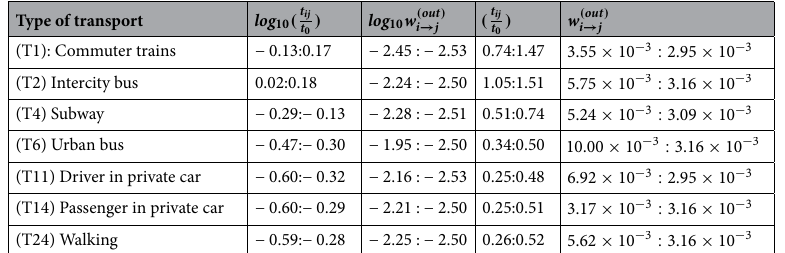
t ij ) and the transition probabilities t 0